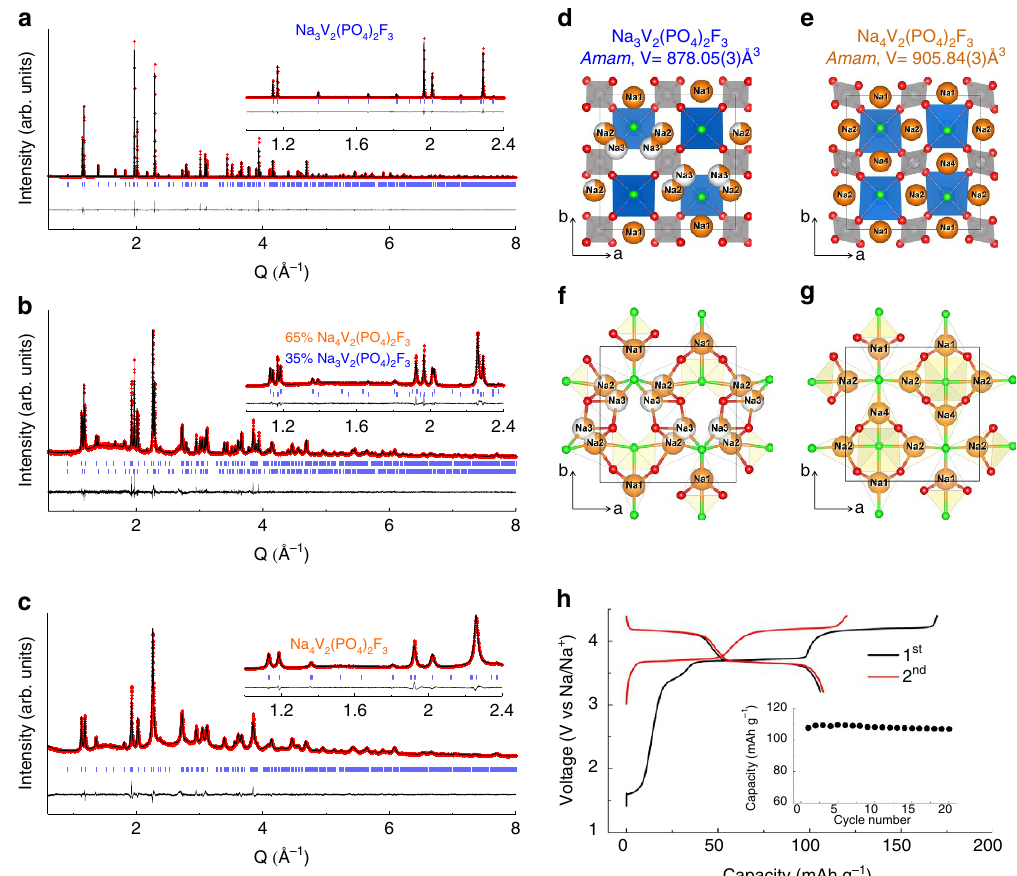
Figure 3 | Synthesis and electrochemistry of Na 4 V 2 (PO 4 ) 2 F 3 by Na reductive ball milling. Rietveld refinements of pristine Na 3 V 2 (PO 4 ) 2 F 3 ( a ), a mixture of Na 3 V 2 (PO 4 ) 2 F 3 and Na 4 V 2 (PO 4 ) 2 F 3 ( b ) and pure Na 4 V 2 (PO 4 ) 2 F 3 ( c ). The red crosses, black continuous line and bottom grey line represent the observed, calculated and difference patterns, respectively. Vertical blue tick bars mark the Bragg reflections arising from the Amam space group. Patterns are given in Q-space for allowing a direct comparison. Structure of Na 3 V 2 (PO 4 ) 2 F 3 ( d , f ) and of Na 4 V 2 (PO 4 ) 2 F 3 ( e , g ) as deduced from the refinement of the